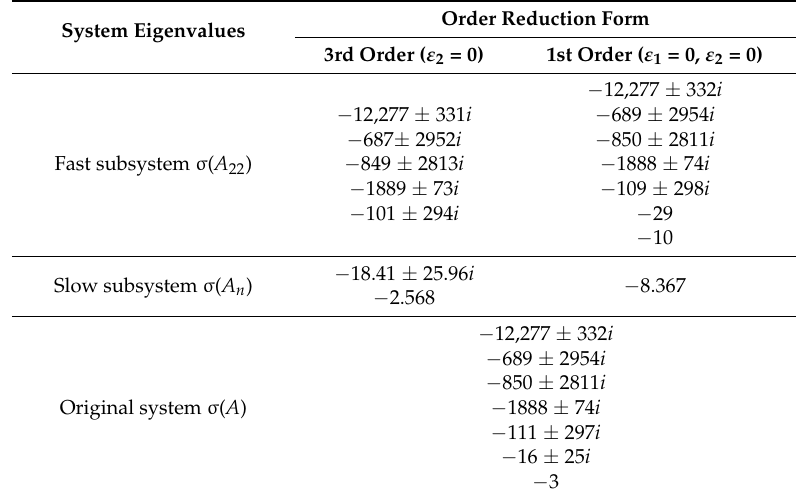
Table 3. Eigenvalues of IIDG models at